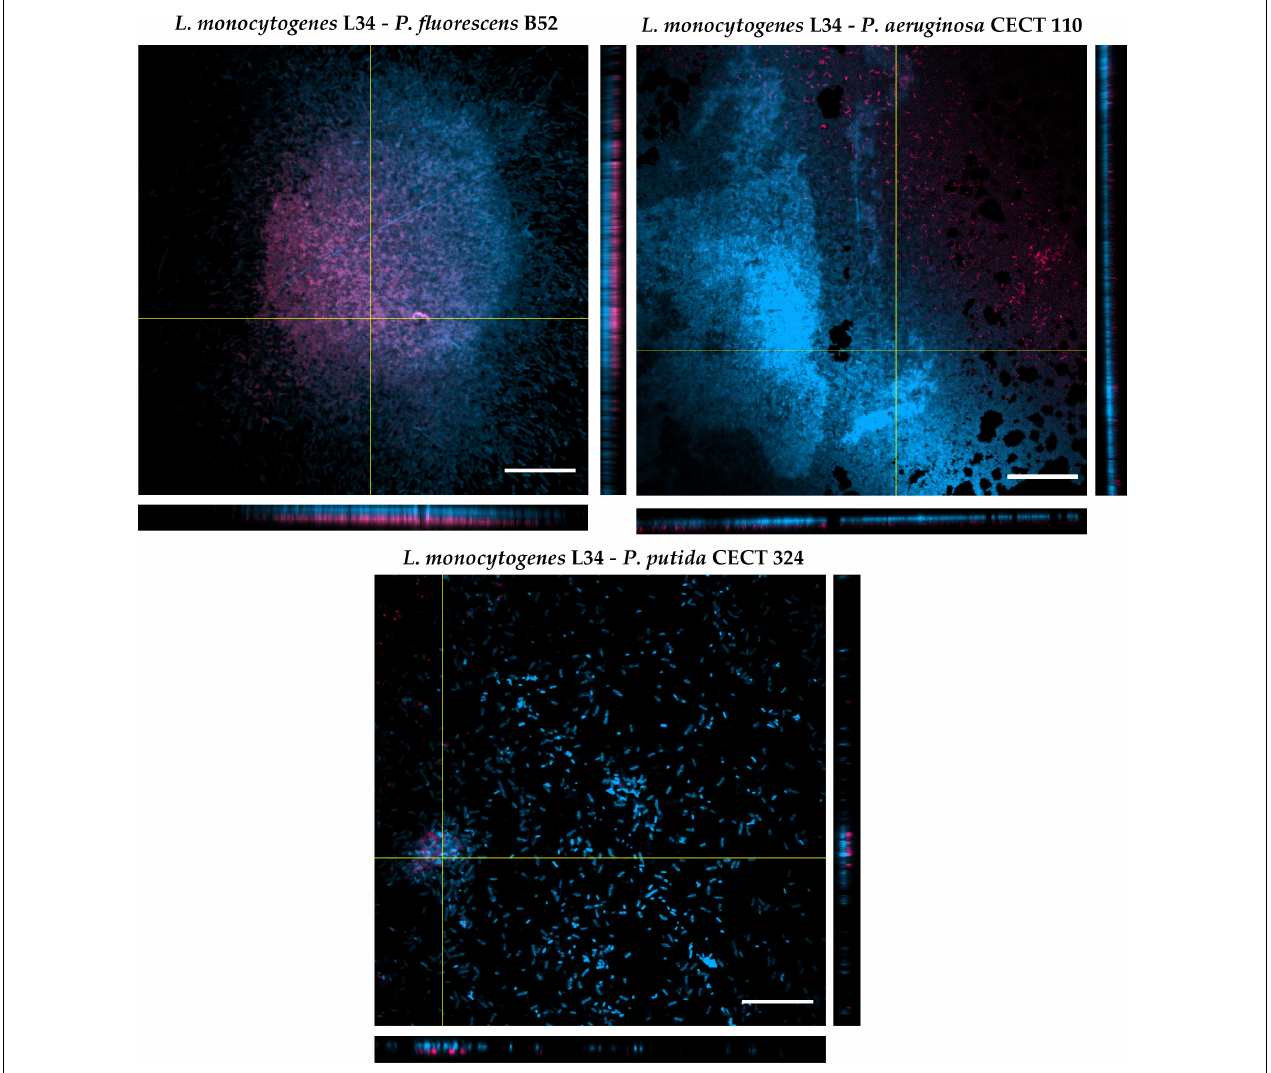
FIGURE 4 | Orthogonal projections of CLSM of the three dual-species biofilms assayed in this study. The images were obtained using a 60 × oil immersion objective. Red signal: Listeria monocytogenes L34. Blue signal: Pseudomonas spp. Scale bar, 20 µ